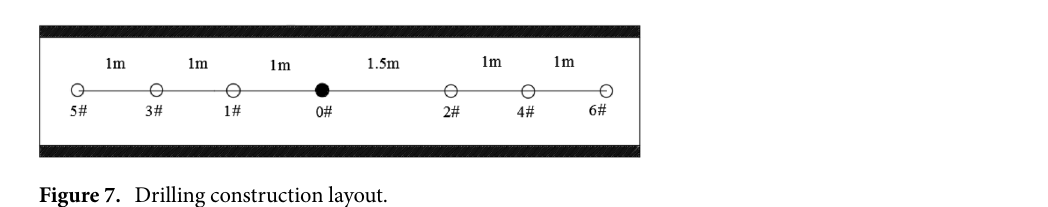
Figure 7. Drilling construction